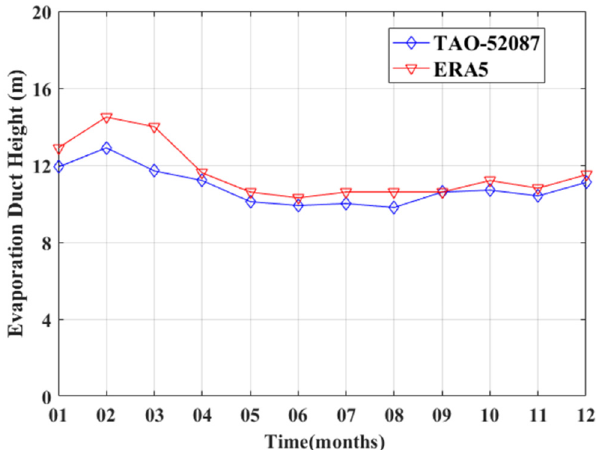
Figure 5. Comparison of EDH calculated by TAO52087 buoy data and ERA5 data in 2020 (monthly averaged).